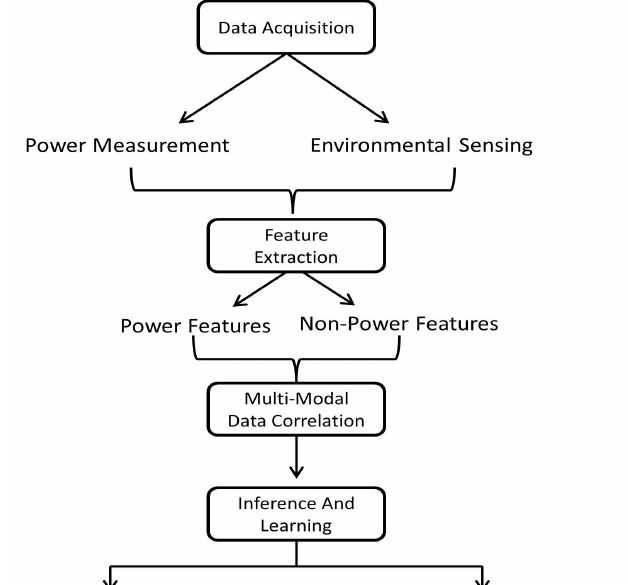
Figure 7. Multi-Modal Sensing Framework for NILM based load